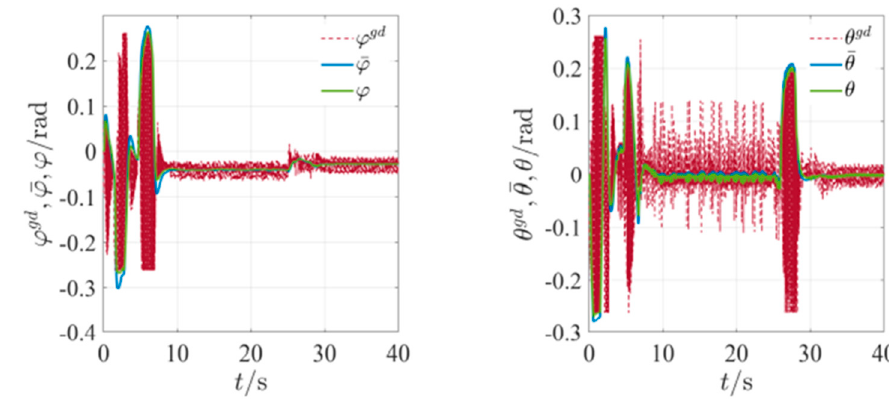
25 of 42 Figure 20. Height diagram of line tracking. Figure 21. Diagram of horizontal velocity of line tracking. It can be found that from 0 to 3 s, the helicopter draws close to the route along the reference trajectory; from 3 to 5 s, the helicopter decelerates in the normal direction of